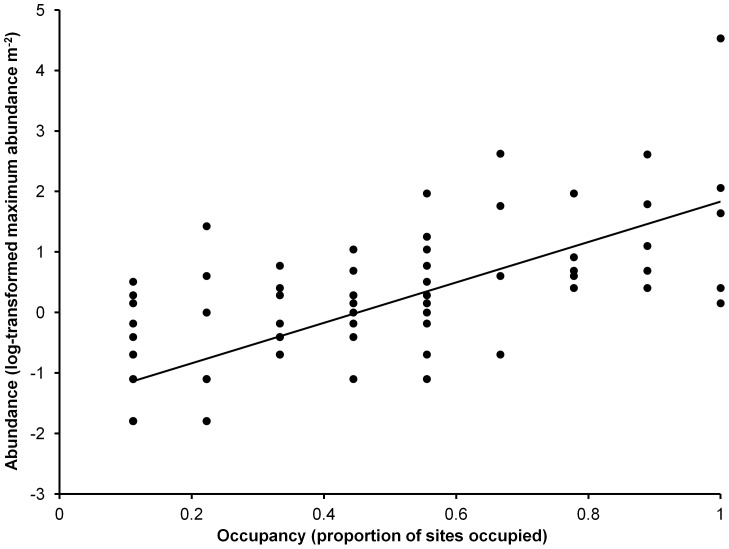
Occupancy-frequency distribution.Relationship between log abundance (maximum of the site-specific abundances) and occupancy. Each data point represents a different species (n = 85).